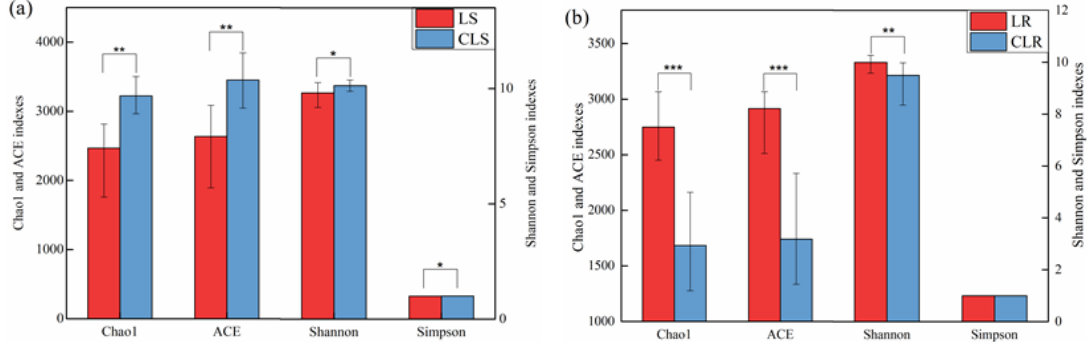
Figure 2. Changes in soil bacterial alpha diversities in mining subsidence area and vegetation rehabilitation area. ( a , b ) are the index of alpha diversity in Daliuta Coal Mine and Heidaigou Coal Mine, respectively. LS and CLS represent samples from the mining subsidence area and control area in Daliuta Coal Mine, respectively. LR and CLR represent samples from vegetation rehabilitation area and control area in Heidaigou Coal Mine, respectively. * p < 0.5, ** p < 0.01, *** p < 0.001